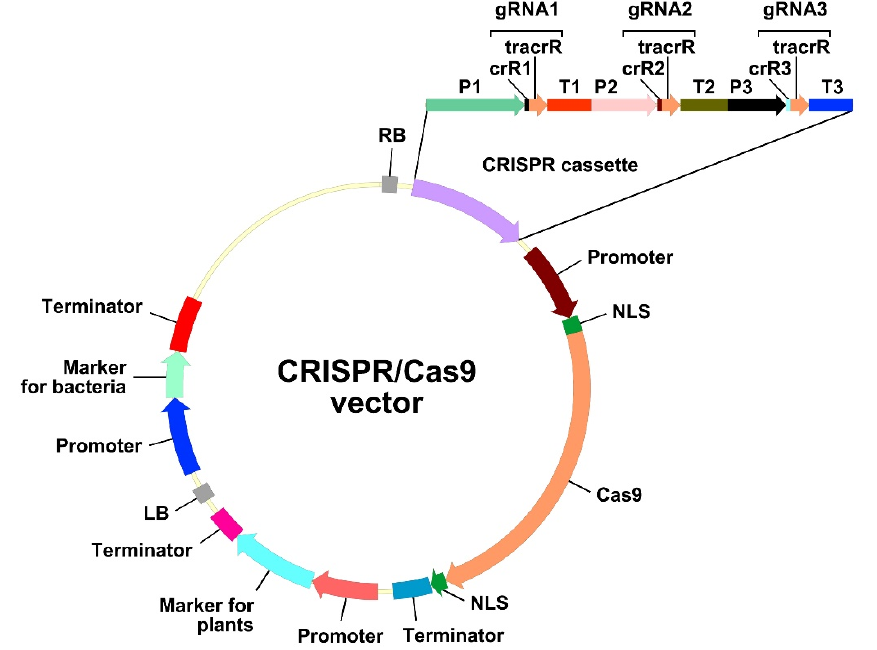
Figure 2. Map of a CRISPR/Cas9 vector. Vector components (clockwise): RB—right T-DNA border; CRISPR cassette containing P—promoter of the small nucleolar RNA ( snoRNA ) gene; gRNA—guide RNA; crR— crisprRNA (target specific); tracrR— trans -activating crisprRNA (conserved, used as a binding scaffold for Cas9); T—terminator of the snoRNA gene; NLS—nuclear localization signal; Cas9—CRISPR associated nuclease 9; LB—left T-DNA border.